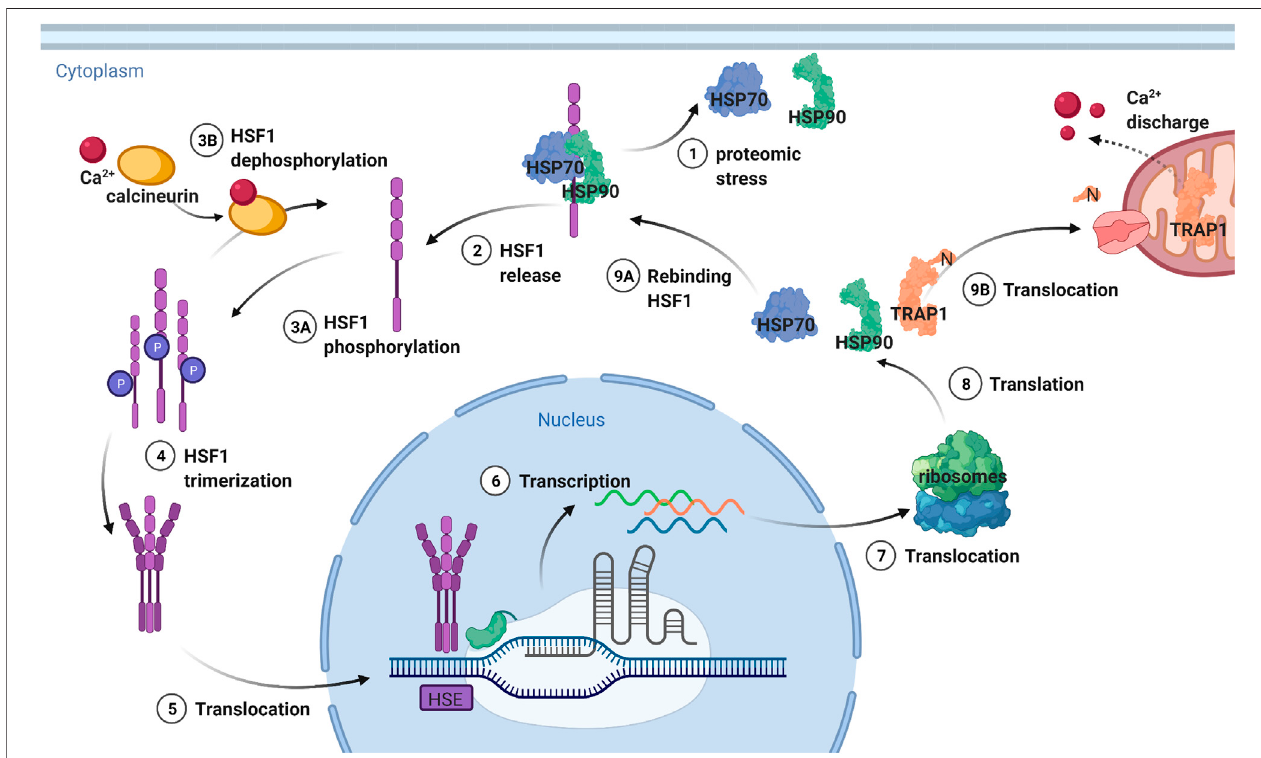
FIGURE 6 | Transcription regulation of TRAP1 and other heat shock proteins by HSF1. HSF1 isdeactivated by a complexformed from HSP70 and HSP90, which release the transcription factor upon proteomic stress. Then HSF1 is phosphorylated and can trimerize, after which it is translocated to the nucleus. The trimerization is needed for recognition of the heat shock elements (HSE) after which transcription takes place. The DNA is then translocated to the ribosomes that translate it to heat shockproteins. TRAP1isthentranslocatedtothemitochondria,wheretheN-terminalsequencetargetingforthislocationiscleaved off.HSP90andHSP70stayin the cytosol, rebinding HSF1 and thereby providing a negative feedback mechanism. Figure made with BioRender.